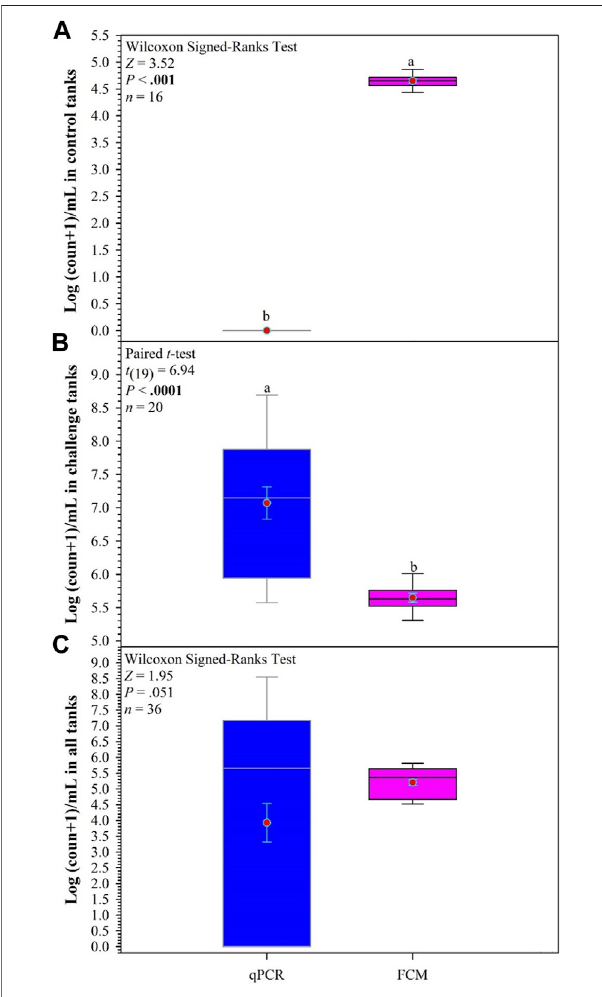
FIGURE 7 | Comparisons between quantitative PCR (qPCR) and fl ow cytometry (FCM) to determine count of F. covae in water samples obtained from control tanks (A) , challenge tanks (B) , and all tanks (C) . Within each box plot, vertical line indicates the median, red dot indicates the mean, and error bars around the red dot represent standard error of the mean. Data with different lowercase letters within same variable differ signi fi cantly at p < 0.05 if bold